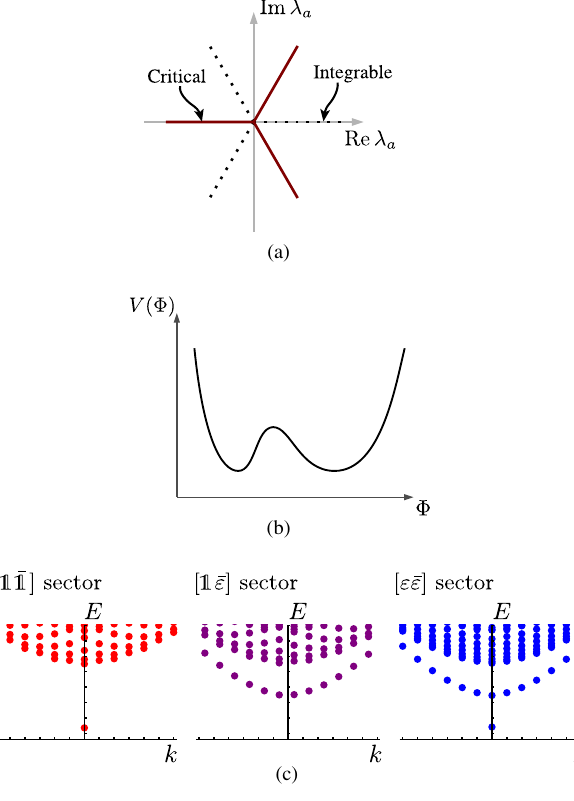
FIG. 7. (a) Phase diagram of the “ ladder ” Hamiltonian in Eq. (71) for complex λ a . At λ a ¼ 0 , the ladder resides at a Z 3 parafermion critical point. Along the three solid lines, the ladder remains gapless but flows instead to the tricritical Ising point. Everywhere else the system is gapped and exhibits two sym- metry-unrelated ground states together with the Fibonacci kink spectrum described in the main text. The dotted lines indicate integrability. (b) Effective double-well Ginzburg-Landau poten- tial of the ladder Hamiltonian, which provides an intuitive picture for the ground-state degeneracy and Fibonacci kink spectrum. The equal-depth wells represent the two ground-state sectors. Excitations in these sectors are nondegenerate and correspond to massive modes about the asymmetric well minima. Kinks and antikinks interpolate between ground states, and turn out to have the same energy as the oscillator excitations in one of the ground states. This is the hallmark of the Fibonacci kink spectrum. (c) Energy versus momentum obtained via the truncated con- formal space approach for each superselection sector. (The ½ ε spectrum is identical to that of ½ 1 ¯ ε (cid:1) with k → − k .) Notice the two ground states, the nearly identical single-particle bands in ½ 1 ¯ ε (cid:1) and ½ ε ¯ ε (cid:1) , as well as the multiparticle continuum in all